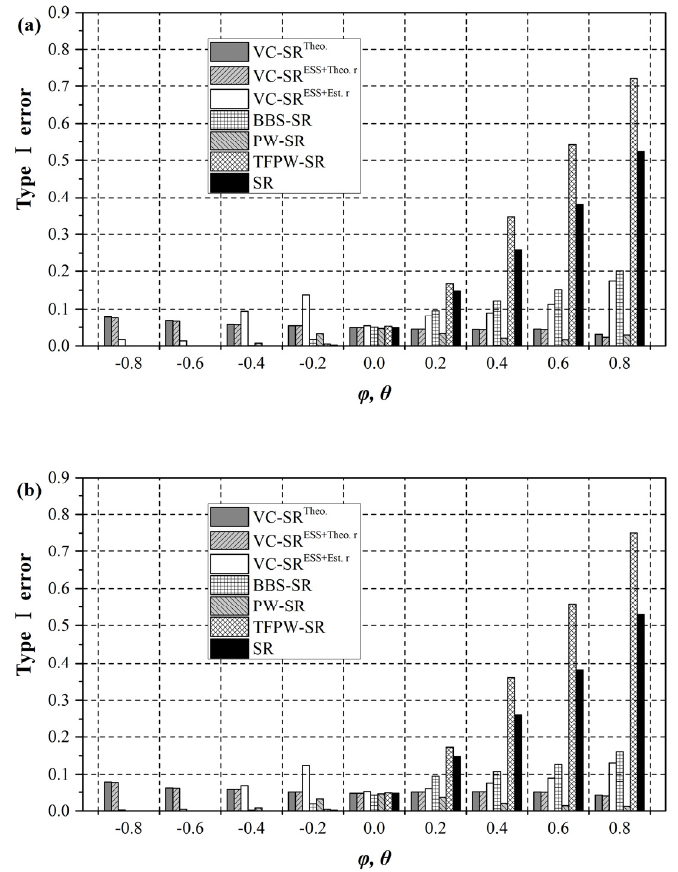
Figure 5. Comparison of Type І errors of different Spearman Rho (SR) tests for ARMA(1,1) series: ( a ) n = 50; ( b ) n = 100.